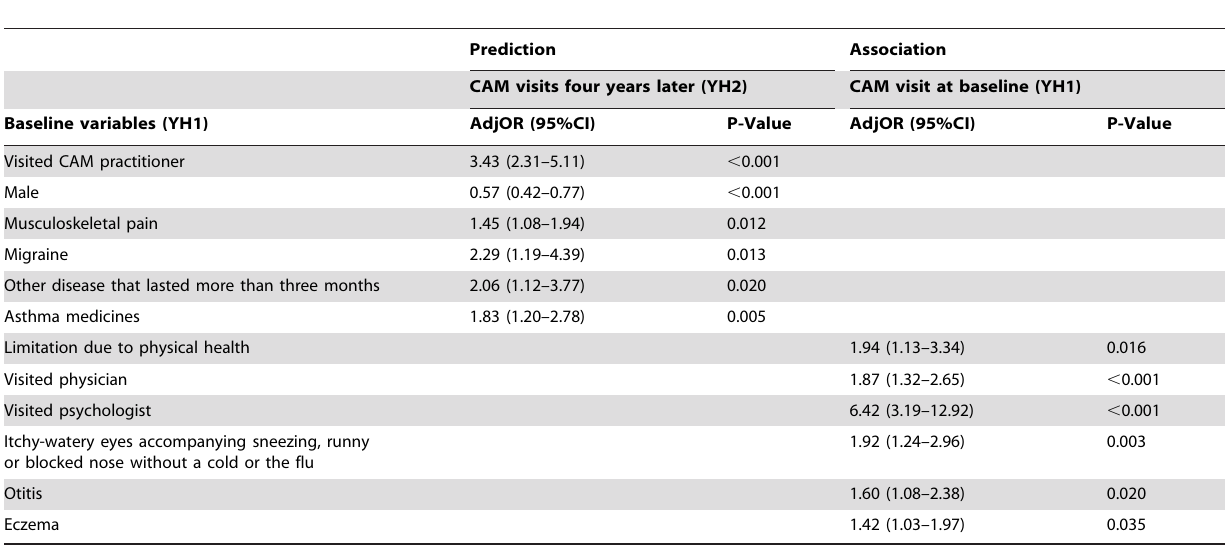
Table 3. The final multivariable logistic regression models of baseline variables 1) predicting CAM visits four years later and 2) associated with CAM visits at baseline (N=